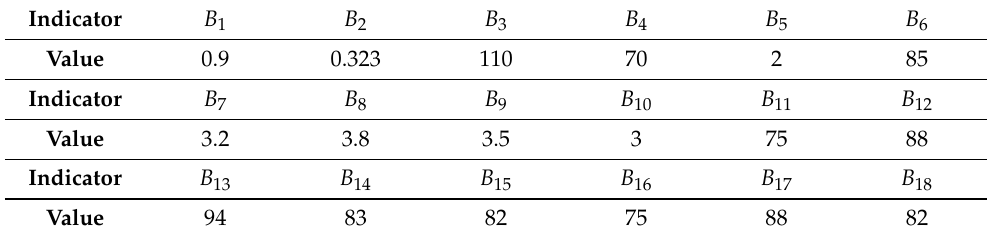
Table 10. Measurements of indicators for the Shangrao project.